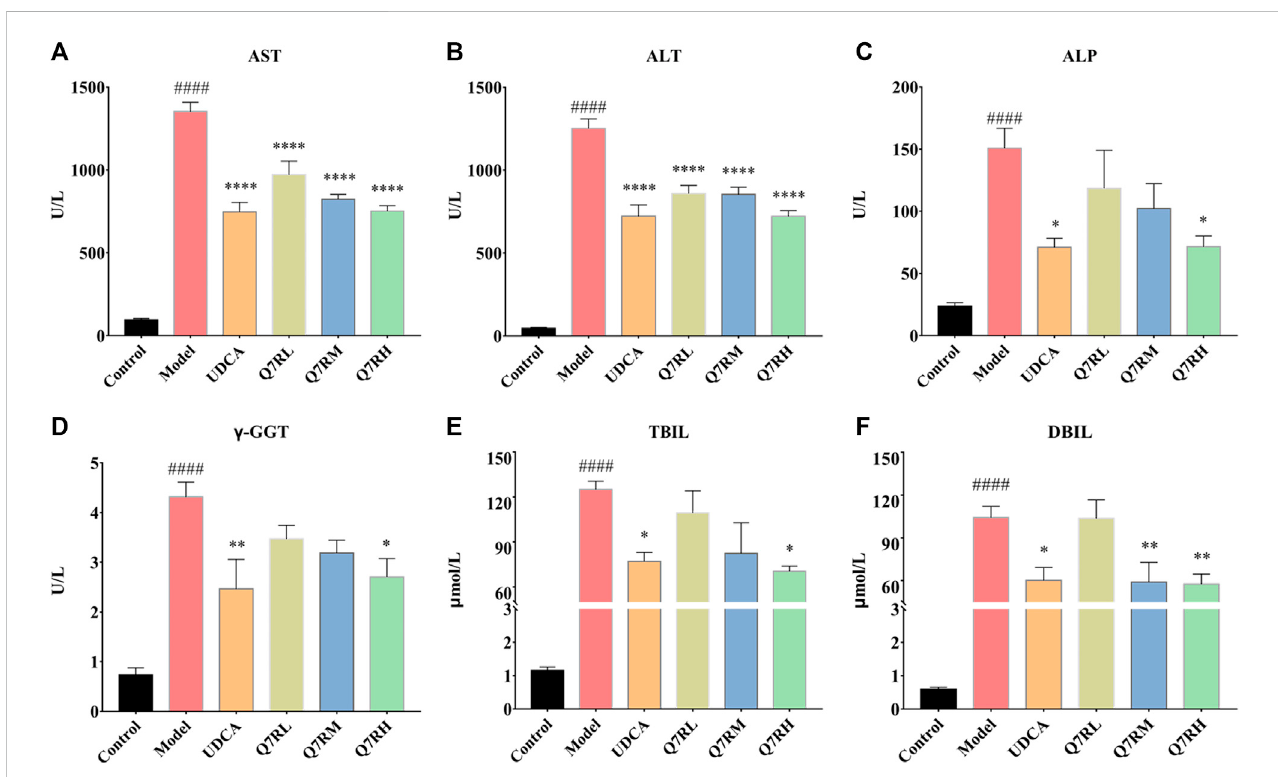
FIGURE 2 EffectofQ7Rtreatmentonthelevelsofserumbiochemicalindicesinmodelrats( n =6). (A) SerumAST; (B) SerumALT; (C) SerumALP; (D) Serum γ -GGT; (E) Serum TBIL; (F) Serum DBIL; Values are presented as mean ± SEM for three biological replicates per group. * p < .05, ** p < .01, **** p < .001 vs. the model group, #### p < .001 vs. the control